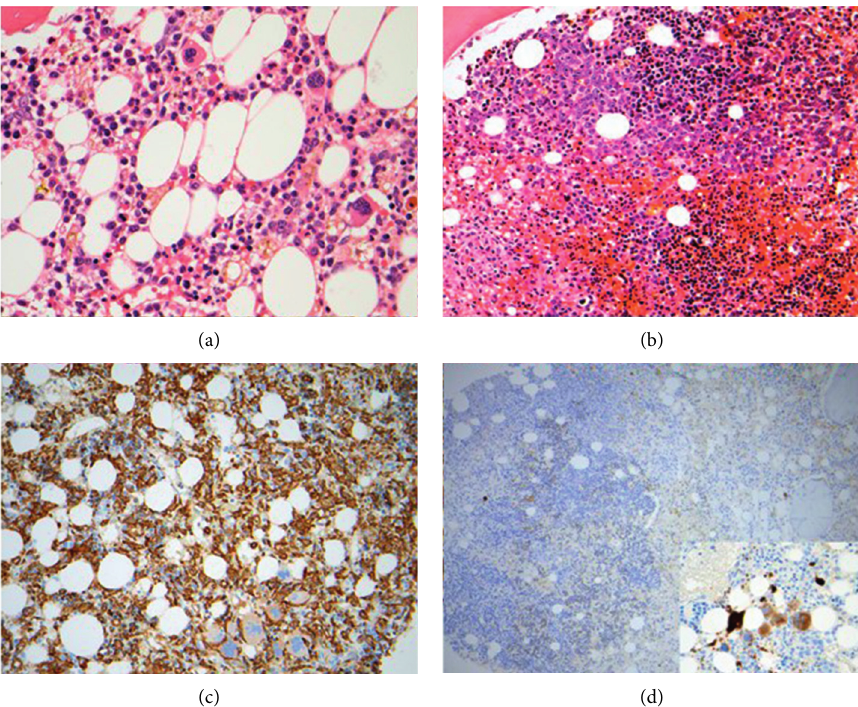
Figure 1: Bone marrow biopsy findings before and after COVID-19 diagnosis. (a) Before SARS-CoV-2 detection, all three main he- matopoietic lineages were visible. There was no significant dysplasia. Erythroid cells were relatively scant and scattered. There was subtle stromal damage. (b) Following SARS-CoV-2 infection, prominent erythroid hyperplasia and signs of stromal damage were observed. Large clusters of erythroid cells were locally synchronised at the same maturational stage (“stress erythropoiesis”). Proerythroblasts showed megaloblastoid features. Erythroid cells approached the trabecular bone. (c) An excess of stromal histiocytes on CD163 immunostaining after SARS-CoV-2 infection. (d) On CD61 immunostaining, profound megakaryocytic deficit and atypia were illustrated after SARS-CoV-2 infection. Table 1: Characteristics of haematology patients with SARS-CoV-2 infection who had simultaneous bone marrow biopsy.